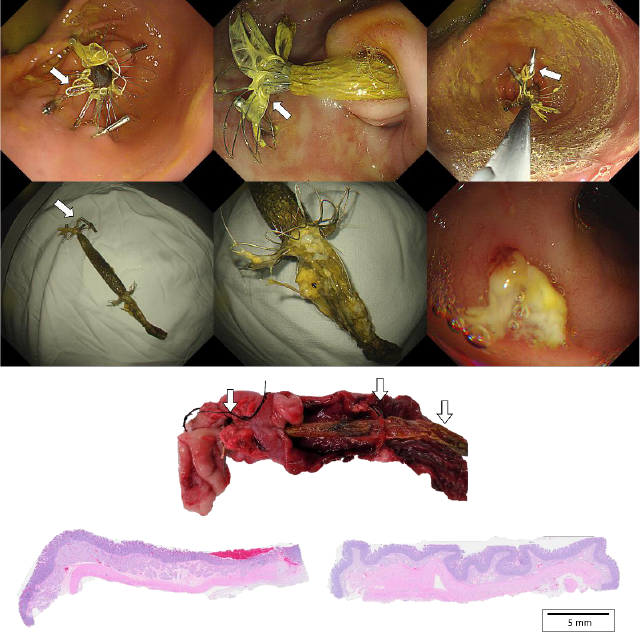
Figure 3. ( Upper ). Endoscopic images of a porcine stomach after deployment of the novel G-DFR. After 90 days of observation, G-DFR was then endoscopically removed. A white arrow indicates a lasso in proximal flaps. ( Middle ). Gross findings showing duodenum with retained G-DFR after necropsy. Both duodenum sections were selected approximately 5 cm away (white arrow) from the pylorus valve where the distal flap of G-DFR was loaded. ( Lower ). Representative histopathological images of the hematoxylin and eosin staining of the duodenum sections collected after 90 days from the case group ( left ) treated with G-DFR and the control group ( right ). In the case group, the duodenum showed mild ulceration and granulomatous formation but no perforation where the distal flap of G-DFR was loaded. G-DFR, Gastro-duodenal flow restrictor.